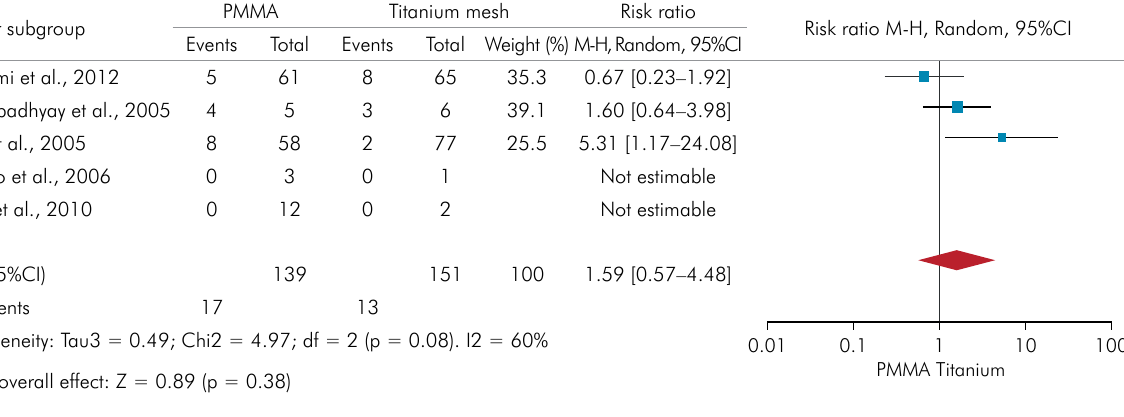
Study or subgroup